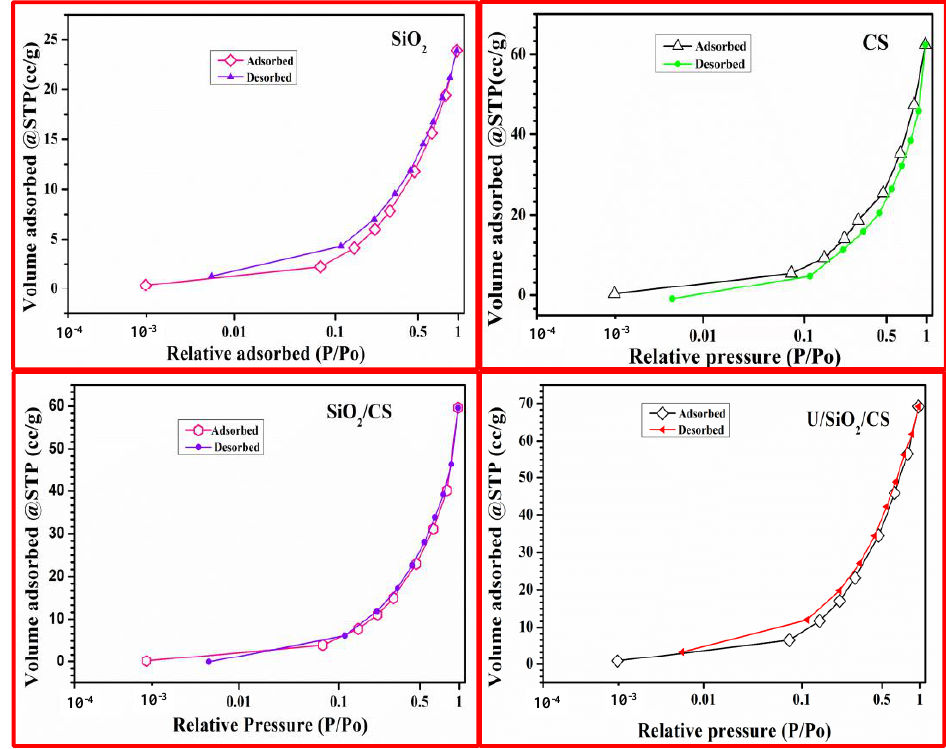
Figure 3. N 2 adsorption/desorption isotherm of SiO 2 , CS, SiO 2 /CS, and U/SiO 2 /CS. Table 1 revealed that the BET surface areas of SiO 2 , CS, SiO 2 /CS, and U/SiO 2 /CS were